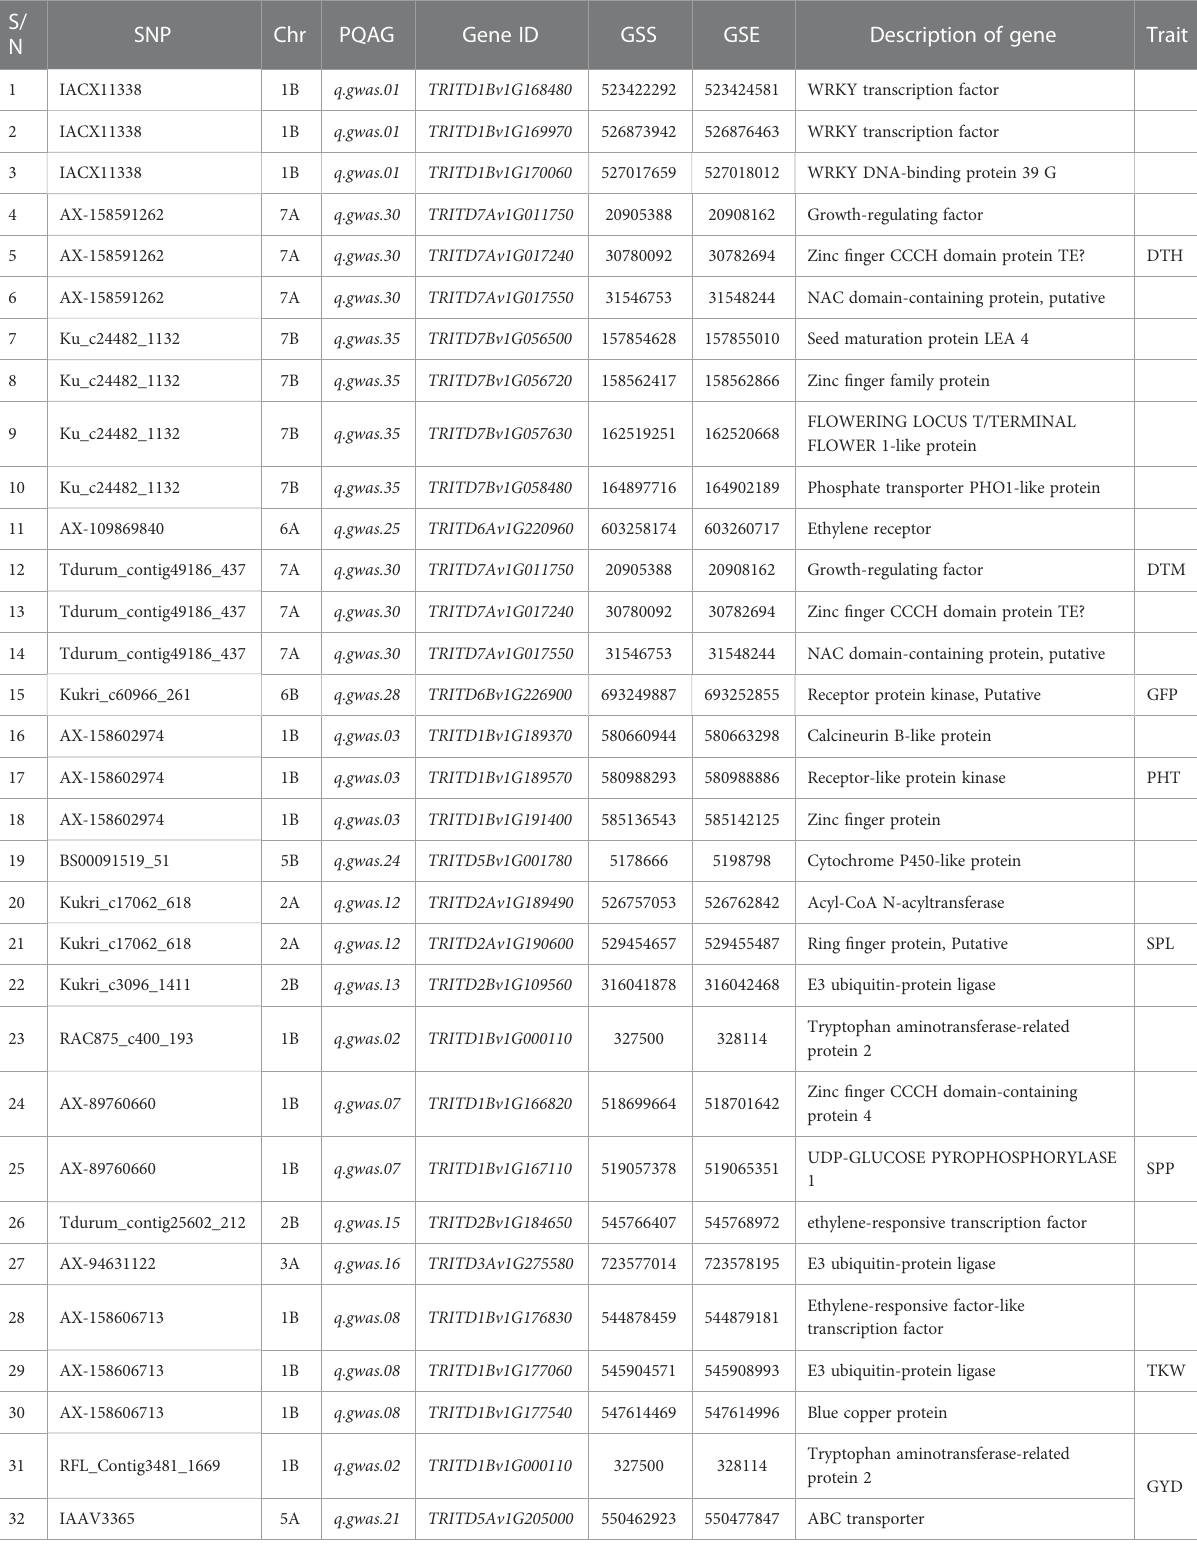
TABLE 6 Summary of selected genes associated with some of the putative QTLs identi fi ed in the present